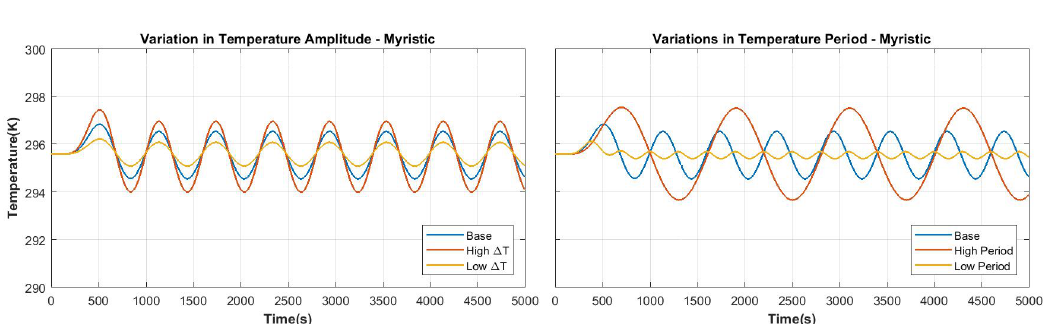
Figure 12. Results of myristic acid at Re = 1000 with amplitudes of 10, 20, 30 K and periods of 5, 10, 20 min. No phase change occurs even with the higher oscillation range and thus the wave simply is scaled. Higher and lower periods result in stretched out and compressed oscillations with higher maximums due to longer diffusion times.